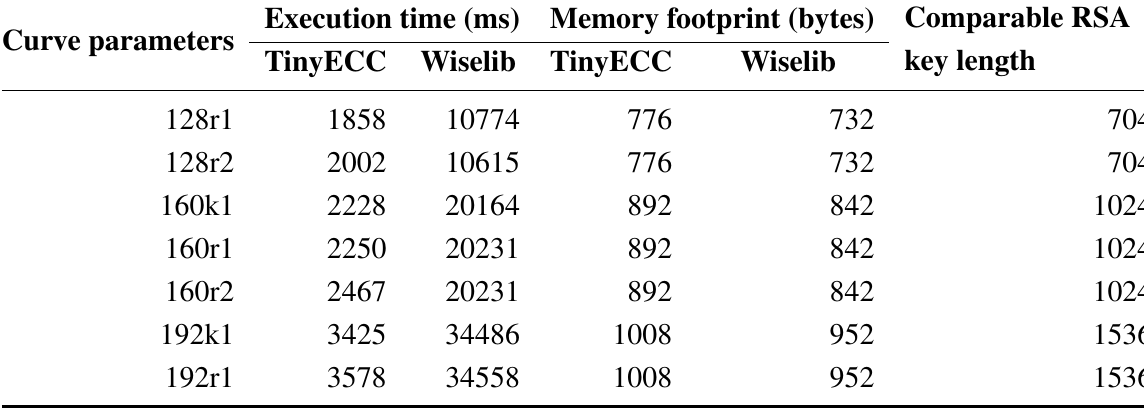
Table 4. ECDSA signature performance: TinyECC versus Wiselib implementations. Curve parameters